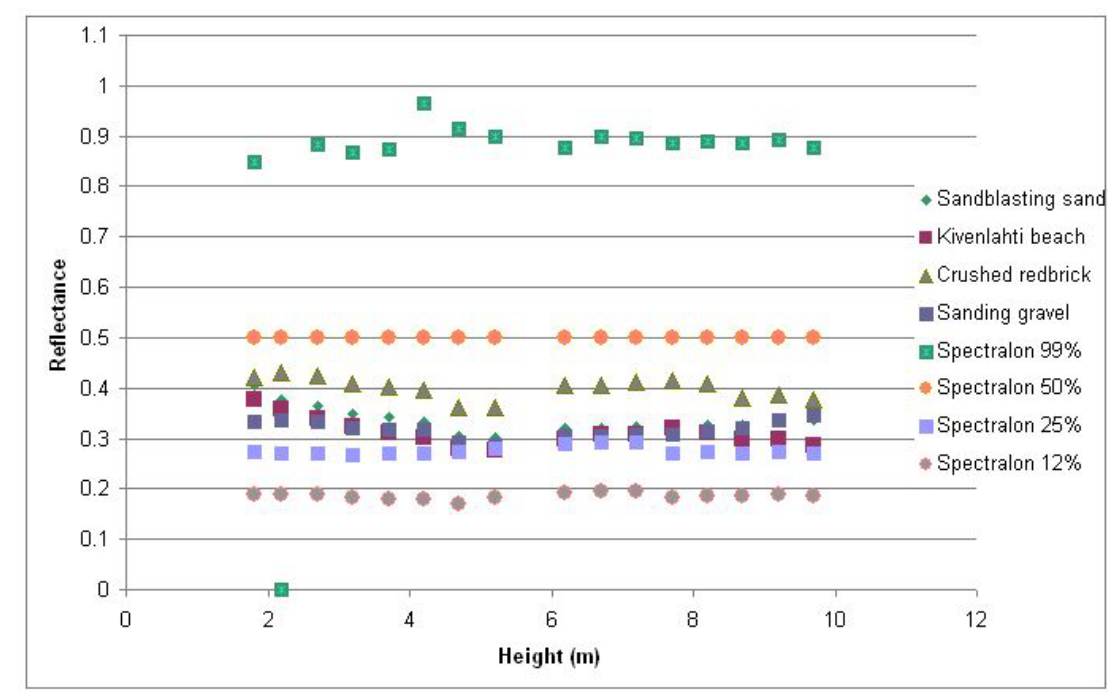
Figure 8. FUJI: 2009 scissor lift experiment, the same targets as for FARO (Figure